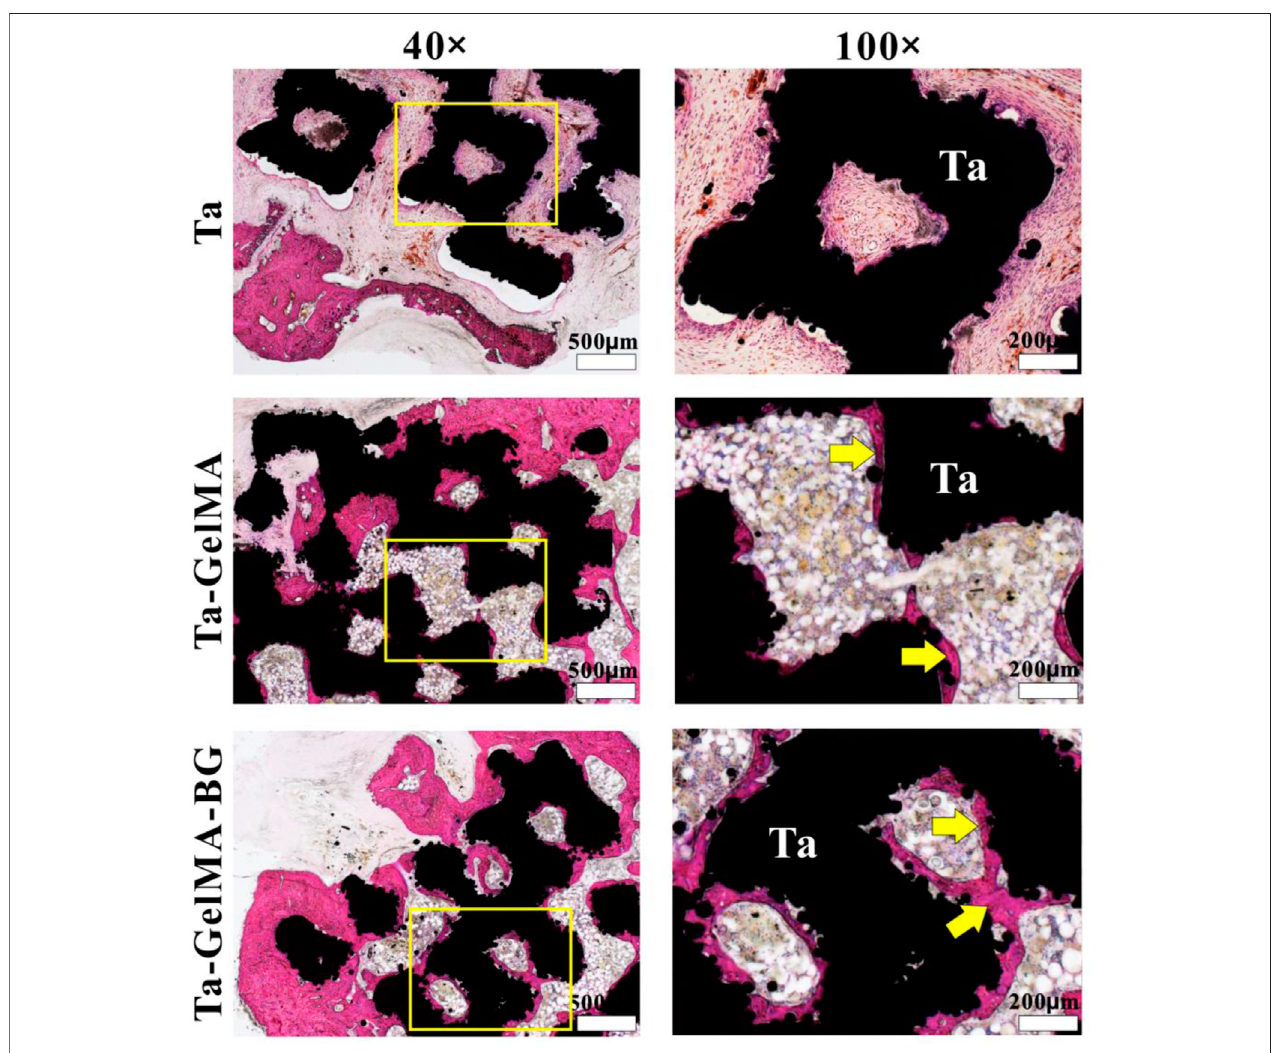
FIGURE 4 | In vivo osteointegration after implantation in femurs defect for 8 weeks by H&E staining. The yellow arrows indicate the newly formed bone.